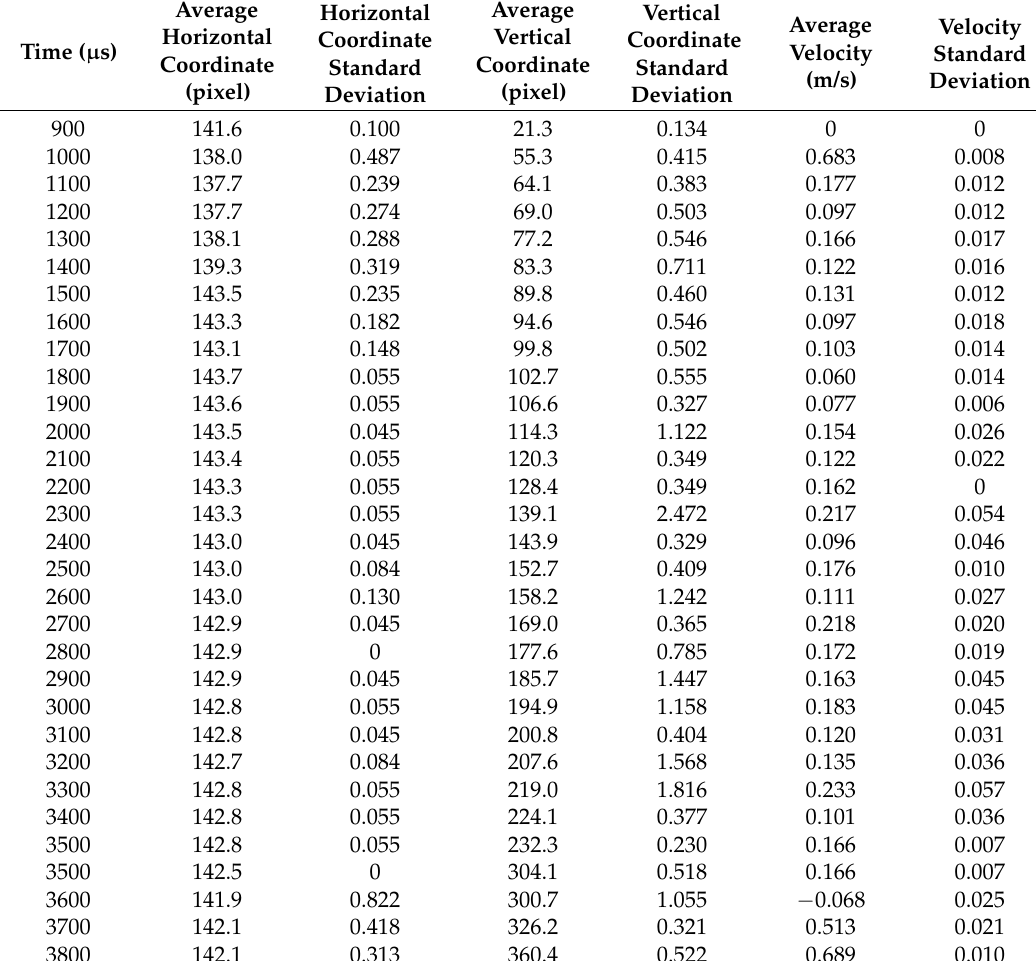
Table 3. Average abscissa, ordinate, and velocity of droplets at different times and their corresponding standard